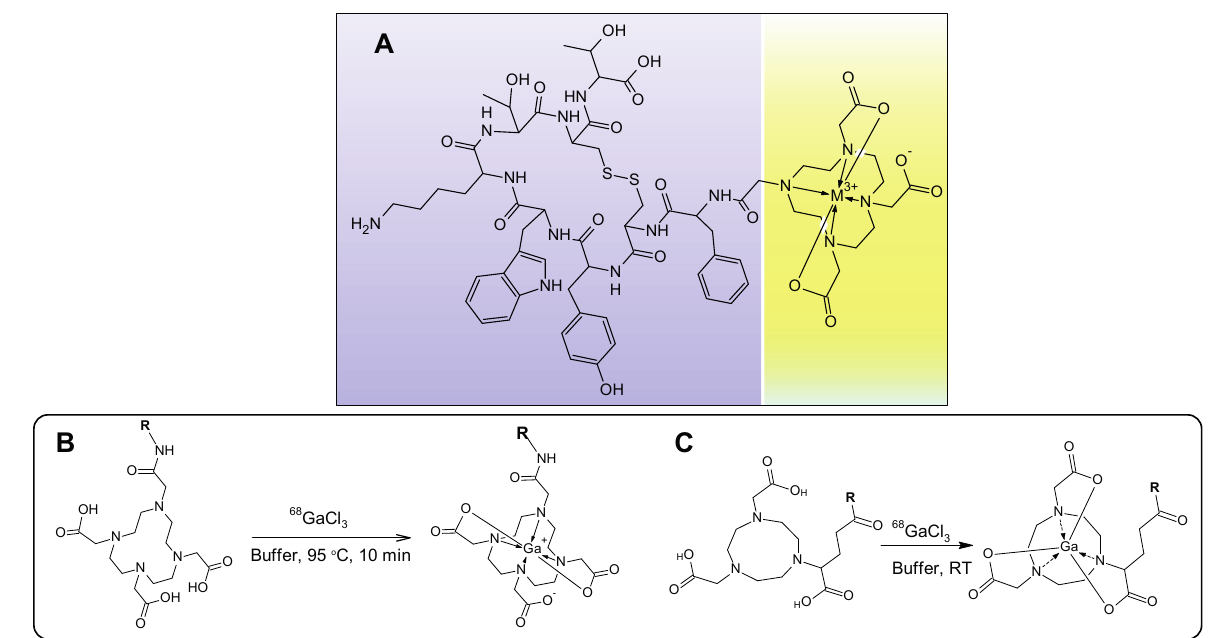
Figure 14. ( A ) Chemical structure of DOTA-TATE where the biologically active vector peptide (TATE, purple background ) is conjugated to DOTA chelate moiety ( yellow background ) encaging the metal cation; ( B , C ) schematic presentation of 68 Ga-labeling , respectively, with DOTA- and NOTA-based ligands, where R stands for a macromolecule such as peptide, protein, oligonucleotide, glycoprotein, antibody or low molecular weight vector that can deliver the radionuclide to the binding